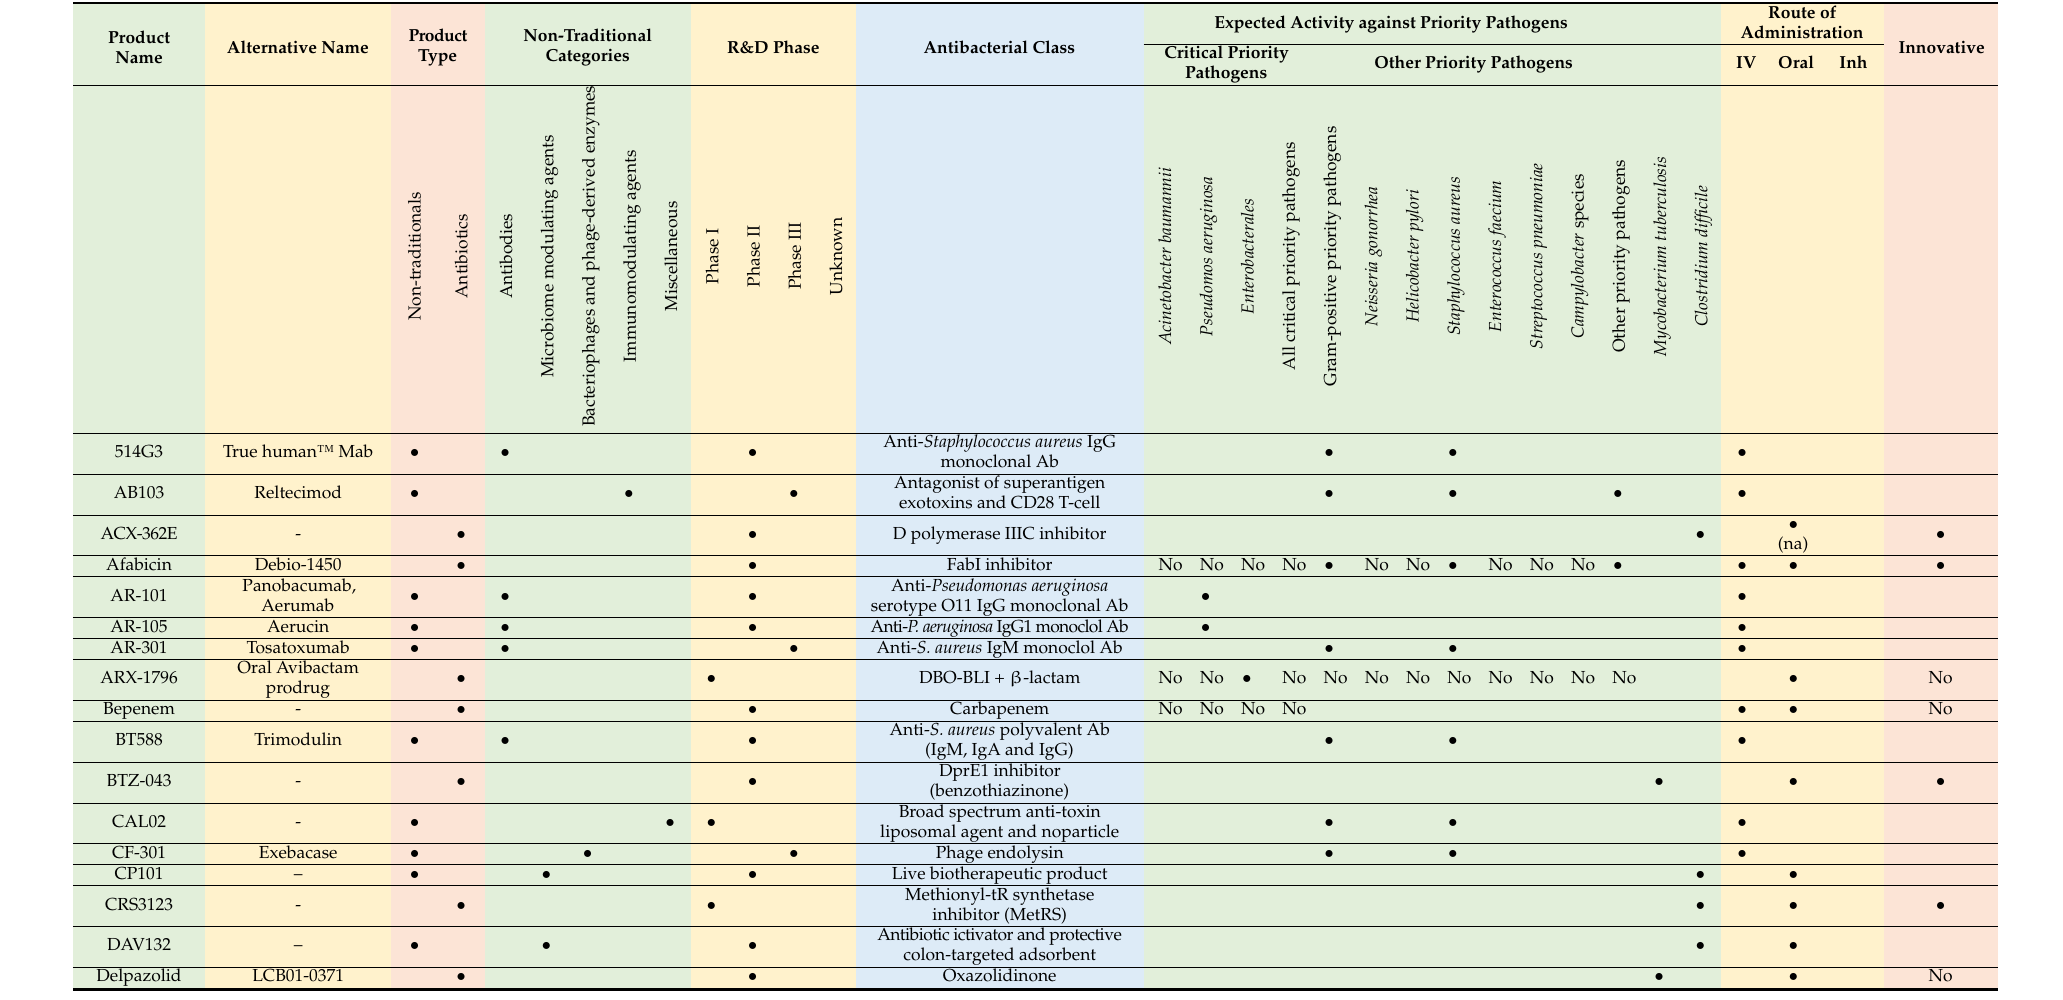
Table 2. A representation of current candidate antibacterial products in current phases of development with their classes, expected activity against pathogens, expected administration route, and